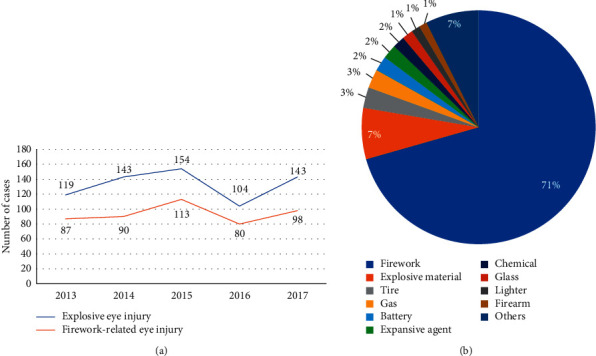
Number of explosive and firework-related eye injuries each year (a) and major causes of explosive eye injury (b). (a) There were an average of 133 ± 20 cases of explosive eye injury and 94 ± 13 cases of firework-related eye injury per year between 2013 and 2017. (b) Fireworks were the major cause (71%) of explosive eye injury, followed by explosive materials (7%) and tires (3%).